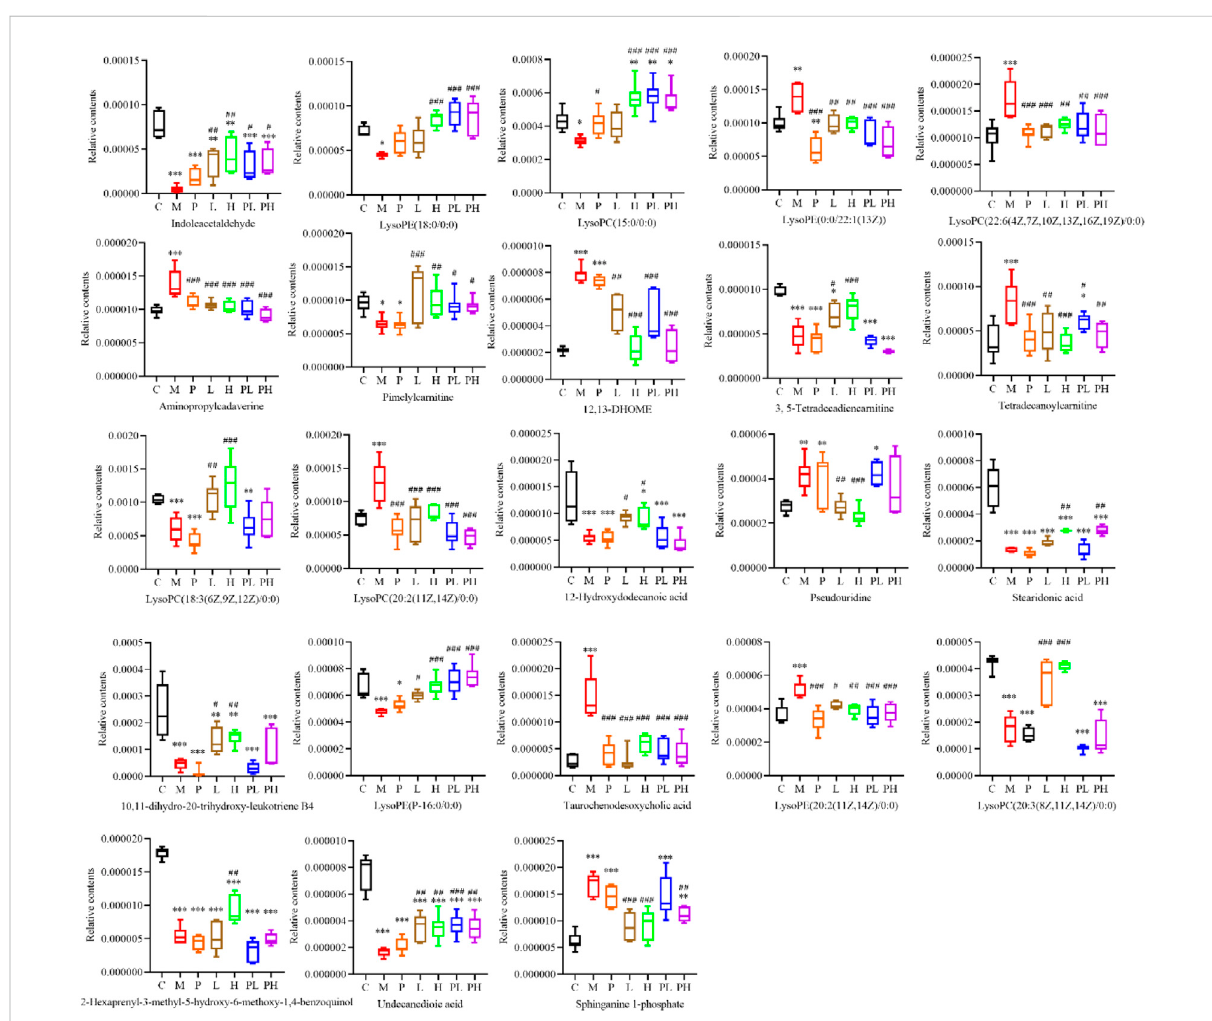
FIGURE 6 GYP signi fi cantly recovered the levels of 23 differential metabolites. Data were analyzed by One-way ANOVA analysis and represented as means±SD(n=6).(C:controlgroup, M:modelgroup,P:cisplatingroup,L:low-doseGYPgroup,H:high-dose GYPgroup,PL:cisplatin+low-dose GYPgroup, PH:cisplatin +high-doseGYPgroup;vs.Controlgroup, * p < 0.05, ** p < 0.01,*** p < 0.001; vs.Model group, # p < 0.05, ## p < 0.01, ### p <